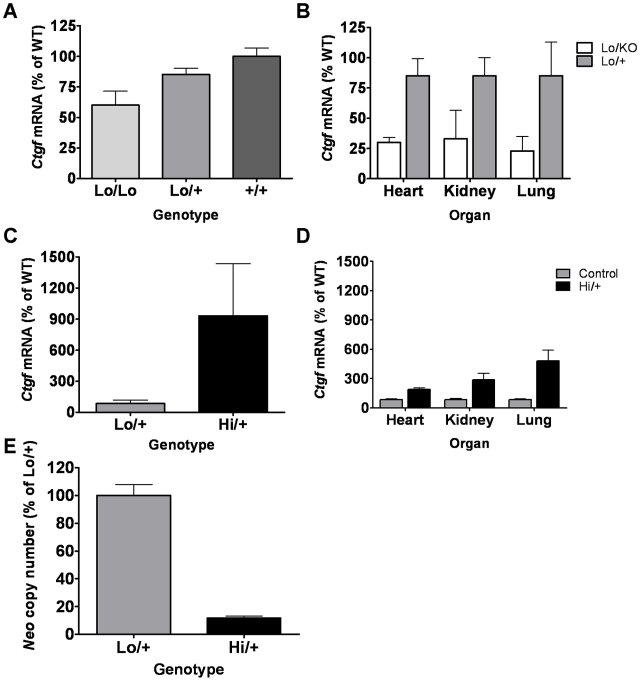

Ctgf mRNA levels by quantitative RT-PCR.A) Ctgf mRNA expression from tail samples of 10 day pups from a cross of Ctgf Lo/+ parents. All mice are siblings. The mean of Ctgf +/+ (wild type) expression is set to 100% expression LoLo: n = 5, Lo/+: n = 25, and +/+: n = 21. B) Ctgf mRNA expression from tissues of five month old mice. Ctgf Lo/+ mice are the control with Lo/+ expression set to 85% based on results from Figure 2A. For each organ Lo/+: n = 14 and Lo/KO: n = 8. C) Ctgf mRNA expression from whole mouse embryos at day points E11.5, normalized to Lo/+ the same as Figure 2B. Lo/+: n = 8 and Hi/+: n = 13 D) Ctgf mRNA expression from tissues of 10 month old mouse tissues normalized to a combined control of animals of the genotypes +/+;Cre-, Lo/+;Cre-, and +/+;Cre+. E) Neo gene copy number in embryos at day E11.5. Copy number is in arbitrary units and normalized to Lo/+ = 100%. Lo/+: n = 18 and Hi/+: n = 28. For all graphs the Lo/+ animals are heterozygous for the Ctgf Lo allele and do not have a Cre allele. The Hi/+ animals are heterozygous for the Ctgf Hi allele and have one EIIa-Cre allele.